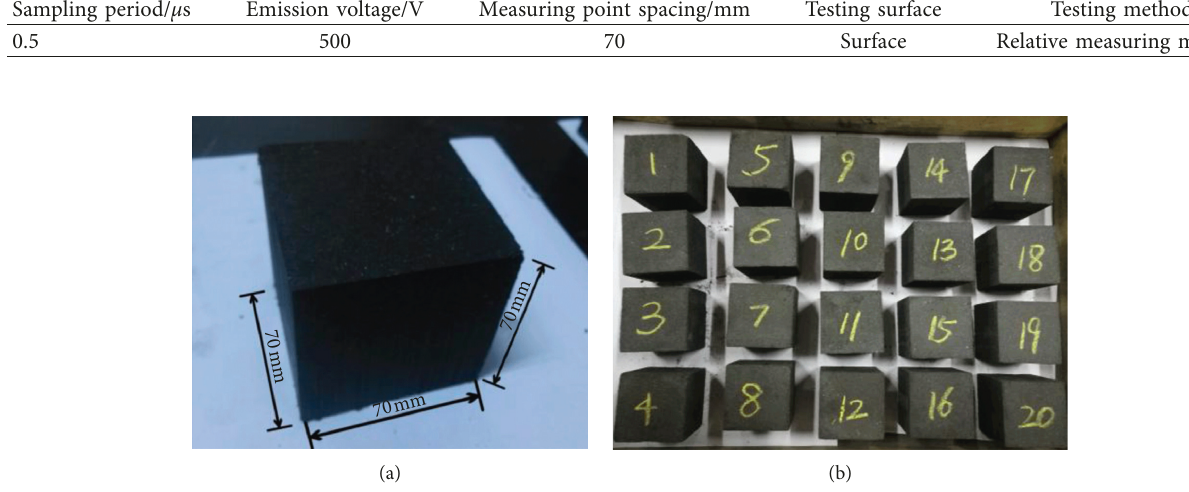
Figure 13: Test Coal Sample. (a) Size of briquette. (b) Briquette samples. Table 4: Relationship between impulse per unit area and pendulum height. Height h /m